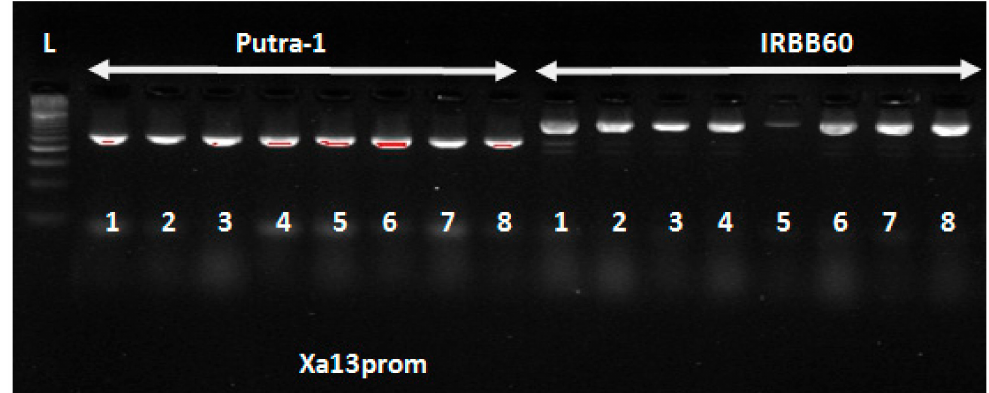
Figure 1. Molecular screening of parental genotypes for polymorphism using Xa13prom foreground marker linked to the xa13